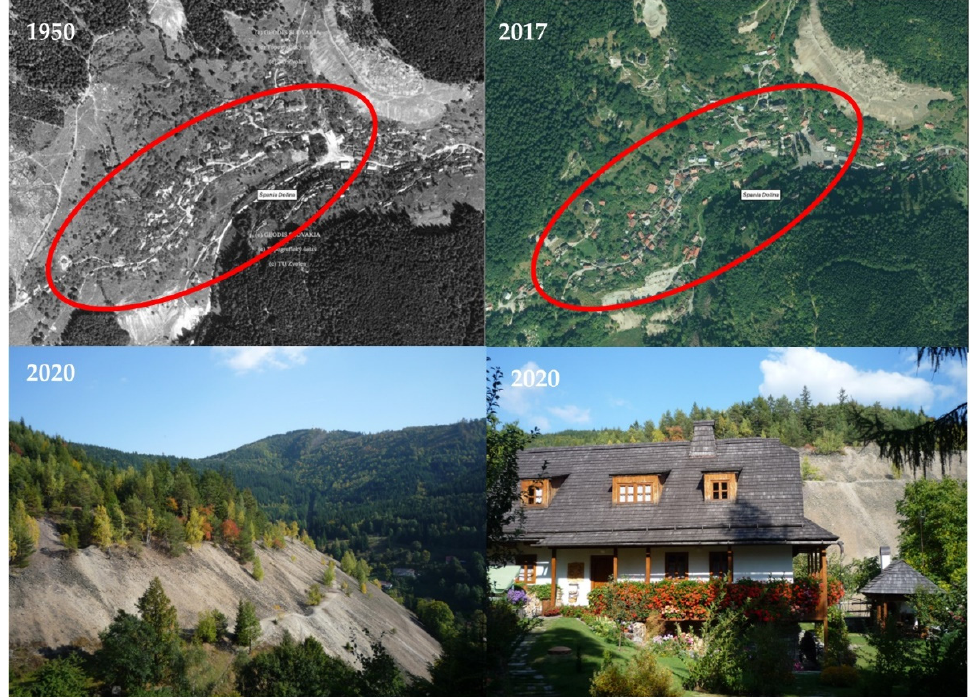
Figure 9. Visual interpretation of the Špania Dolina site. Source: 1950—Adapted with permission from ref. [37]. Copyright 2021 GEODIS SLOVAKIA, s.r.o. Bratislava, Topografický ústav Banská Bystrica. 2017—Adapted with permission from ref. [38]. Copyright 2021 GKÚ Bratislava, NLC Zvo-